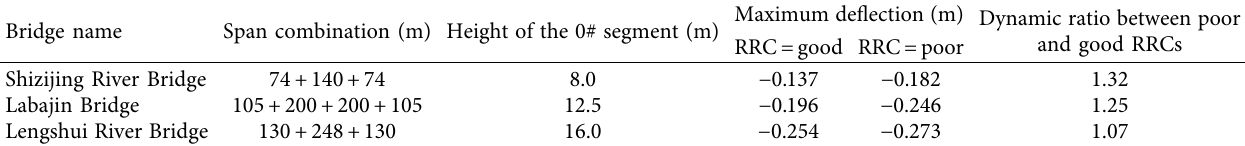
Table 1: Critical parameters of three continuous rigid-frame bridges.